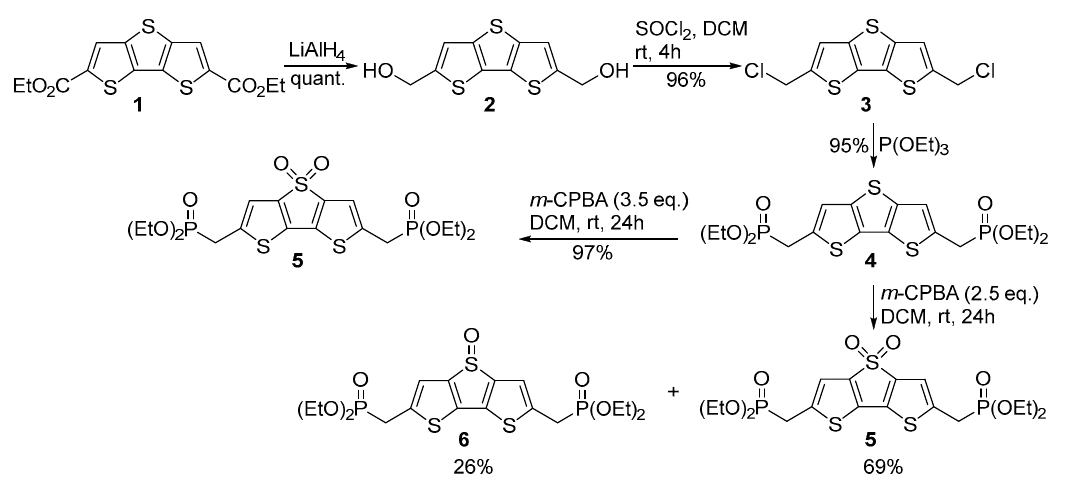
Scheme 1. Synthesis of bisphosphonate 5 . Table 1. Optical properties of unoxidized and oxidized bisphosphonates 4 – 6 recorded in dichloromethane.